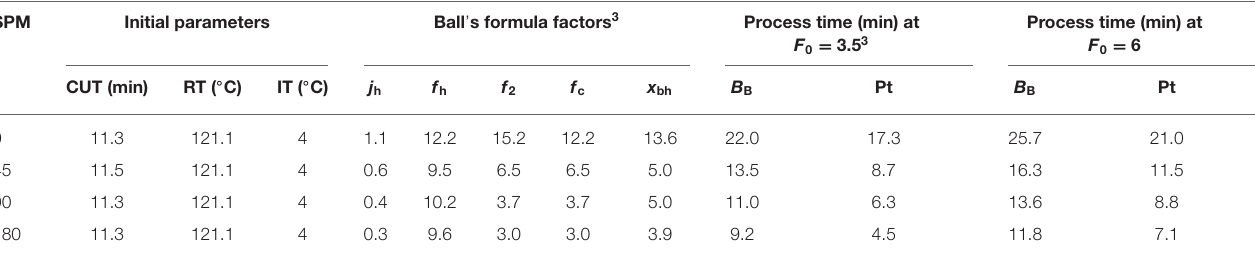
TABLE 2 | Ball’s formula method parameters, factors, and cook time using slowest heat penetration data for 0, 45, 90, and 180 SPM of retorted Louisiana Gulf Coast (LGC) brown shrimp 1,2 . SPM Initial